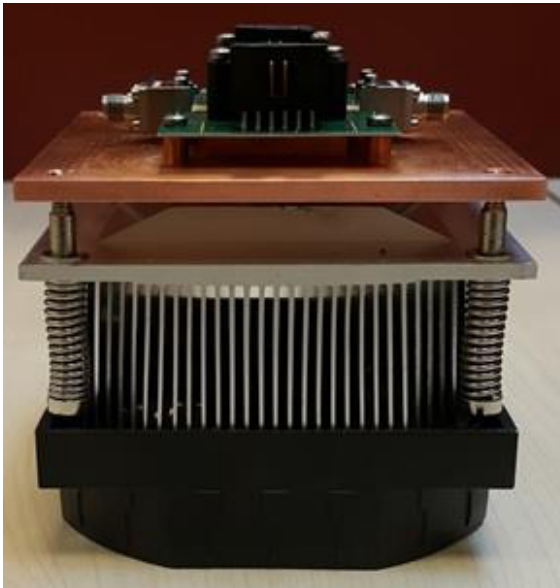
Figure 7: Assembly of cooler